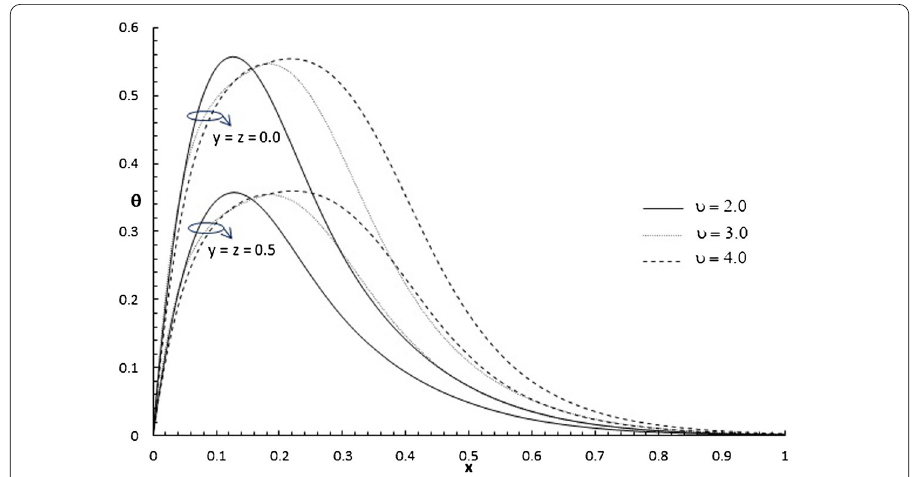
Figure 2 The temperature increment distribution for various values of heat source speed